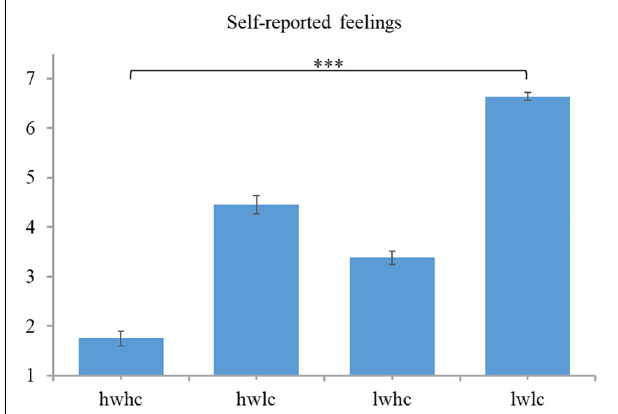
FIGURE 6 | Descriptive statistics and contrasts for the LPP (hw, high warmth; lw, low warmth; hc, high competence; lc, low competence; ∗∗ p ≤ 0.01 and ∗∗∗ p ≤ 0.001).